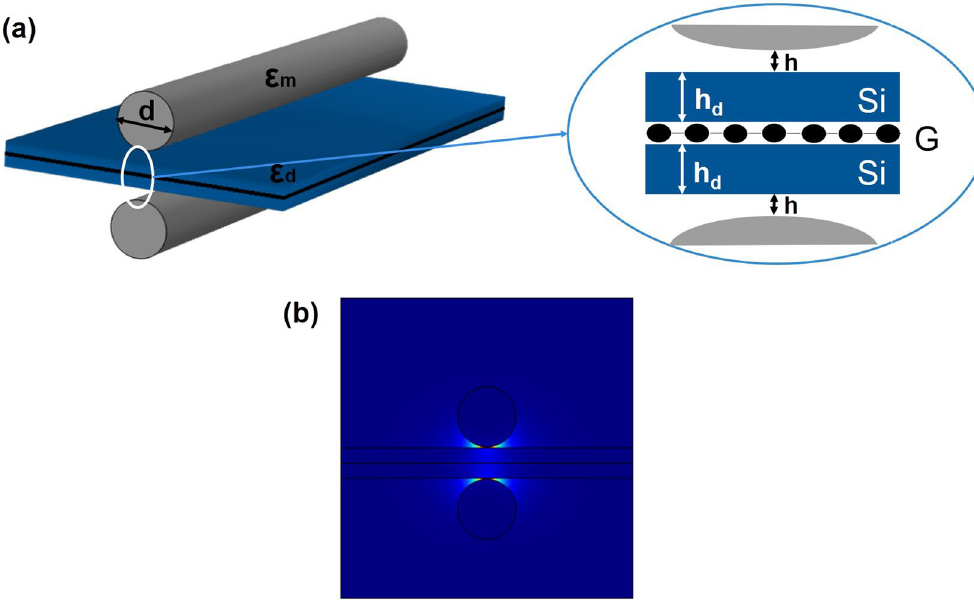
Figure 5. The structure and mode distributions of SGHPM. ( a ) Three dimensional structure of the hybrid modulator. ( b ) The mode distributions of the designed modulator at the wavelength of 1550 nm where d = 200 nm, h = 4 nm and h d = 50 nm.